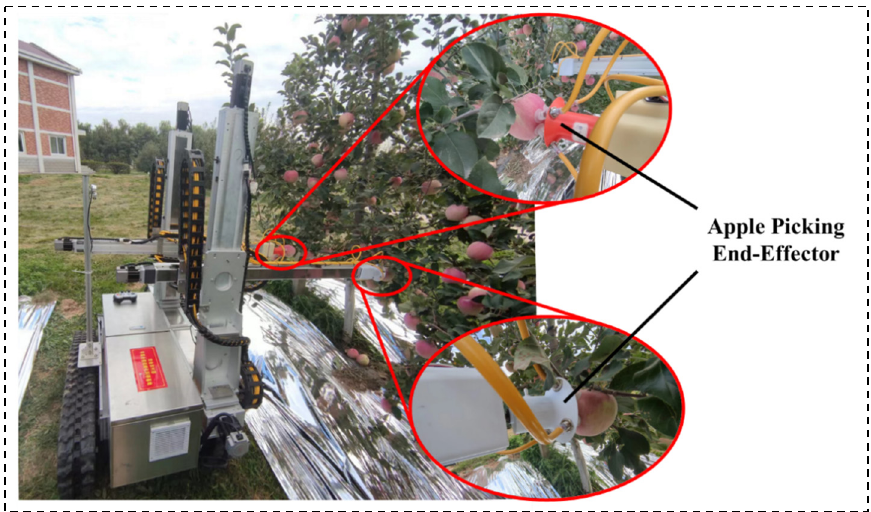
Figure 35. Apple-picking robot equipped with the designed mechanical hand.